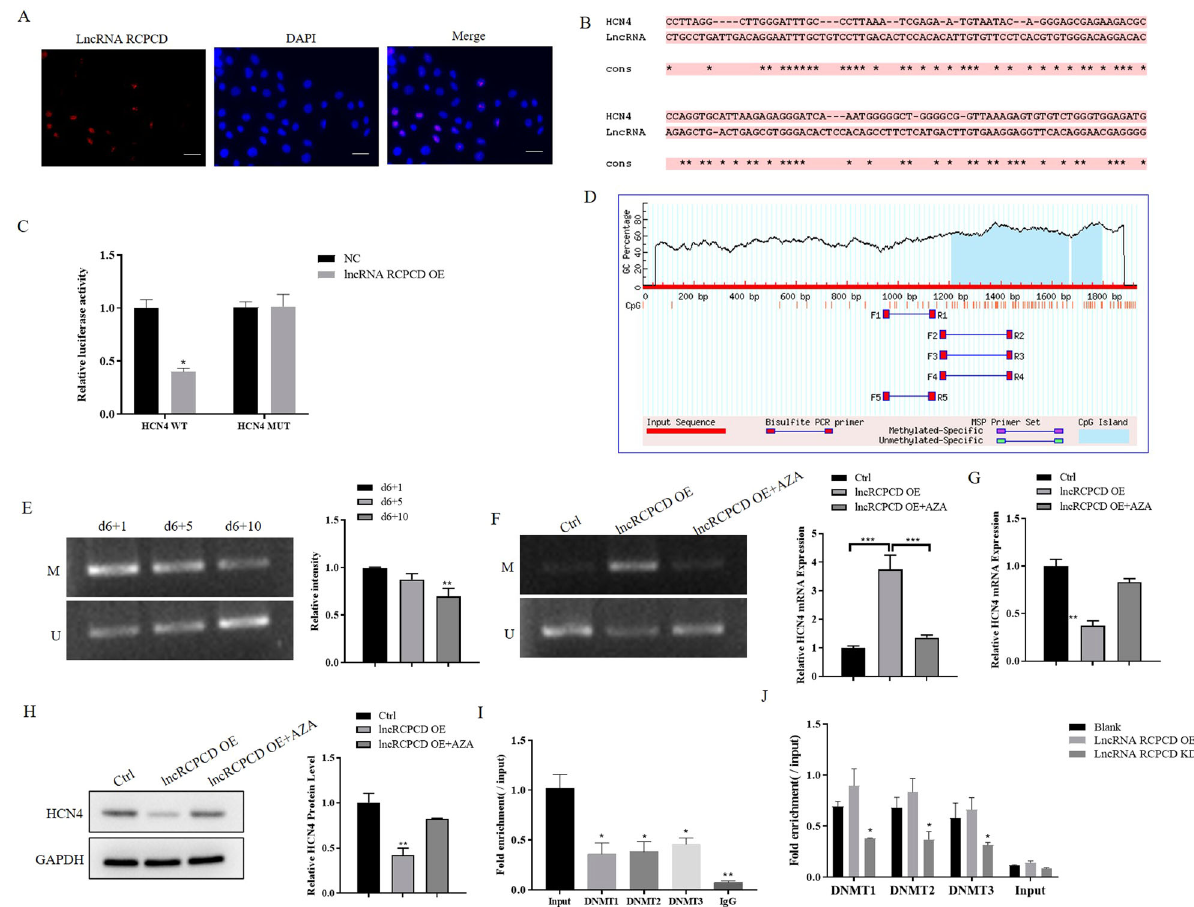
Fig. 5 LncRNA RCPCD inhibited the expression of HCN4 by regulating the methylation of HCN4 promoter region. ESCs were cultured in a differentiation medium to form pacemaker-like cells. RCPCD adenovirus was transfected into differentiated ESCs when cultured 3 days and 6 days. In addition, AZA was added into the differentiated medium at day 3, day 6, and cultured 48 h. A FISH assay veri fi ed the localization of RCPCD in differentiated ESCs at d6 + 10. B RCPCD and HCN4 binding sites. C Luciferase reporter gene assay was used to con fi rm the target binding of RCPCD and HCN4 in 293 T cells. D Methprimer predicted the distribution of CpG island in the HCN4 gene promoter region. E MSP assay detected methylation levels in d6 + 1, d6 + 5, and d6 + 10 differentiated ESCs. F Methylation levels in control, RCPCD transfected, RCPCD transfected and AZA treated group differentiated ESCs at d6 + 10 were detected by MSP assay. G qRT-PCR detected the expression of HCN4 in control, RCPCD transfected, RCPCD transfected and AZA treated group differentiated ESCs at d6 + 10. H Western blot detected the expression of HCN4 in control, RCPCD transfected, RCPCD transfected and AZA treated group differentiated ESCs at d6 + 10. I The expression of RCPCD, which interacts with DNMTs, was detected by CHIP-qRT-PCR in differentiated ESCs at d6 + 10. J The expression of RCPCD, which interacts with DNMTs, was detected by RIP-qRT-PCR in RCPCD overexpression or knockdown differentiated ESCs at d6 + 10. * P < 0.05, ** P < 0.01, * as the difference that compared with the control group or input samples. Error bars were represented the mean ± SD in triplicate